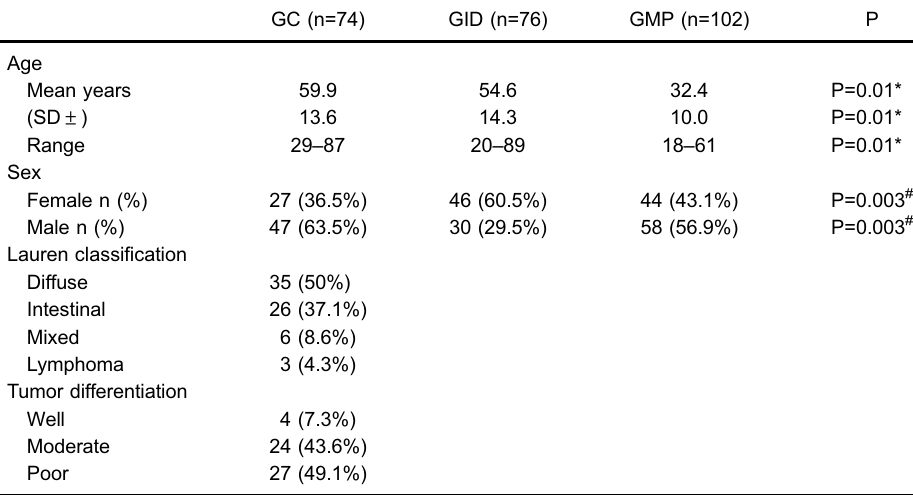
Table 1. Demographic data of the studied